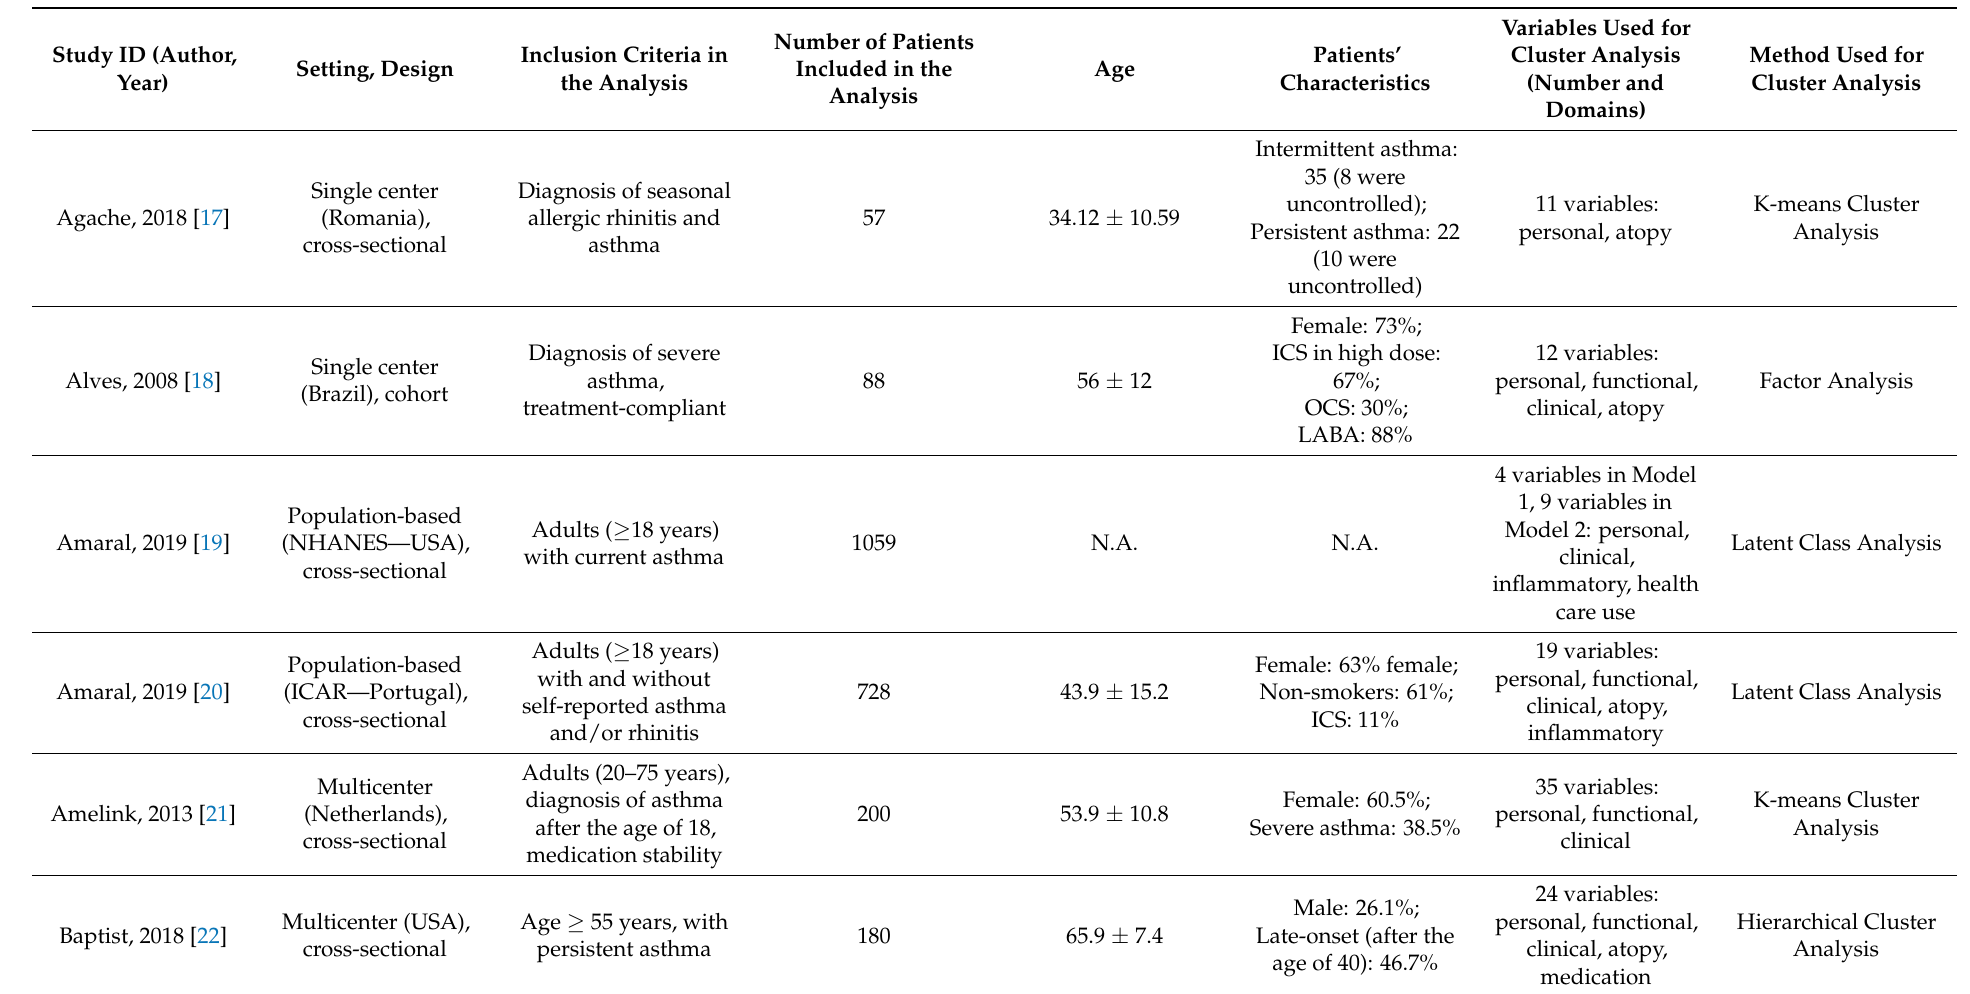
Table 3. Characteristics of the included